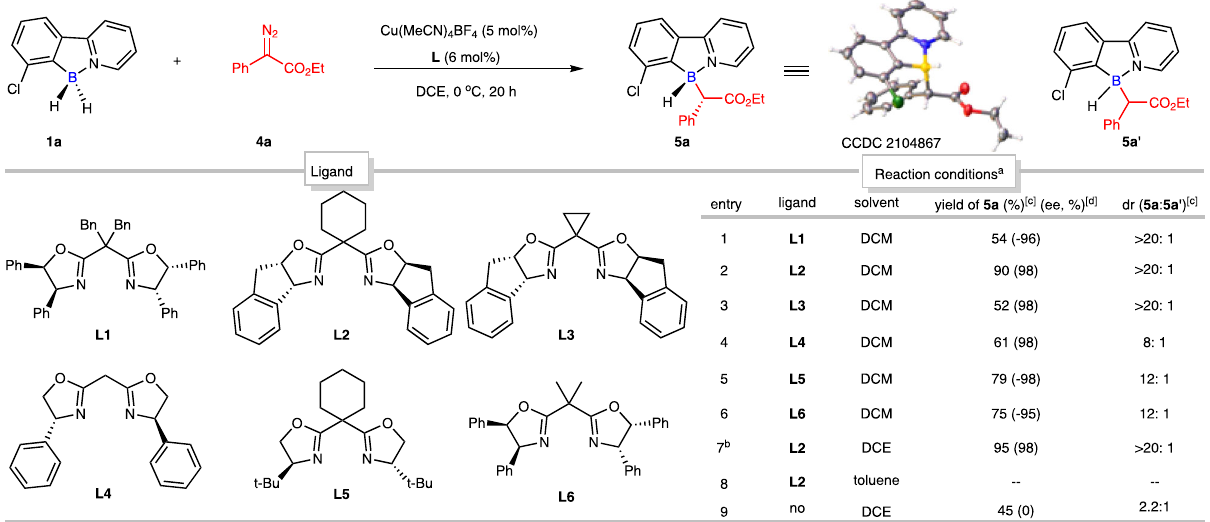
Fig. 6 Optimization of desymmetric B – H bond insertion reaction with ethyl α -diazophenylacetate (4a). Conditions: a 2-arylpyridine-borane ( 1a ) (0.12 mmol, 1.2 equiv), ethyl α -diazophenylacetate ( 4a ) (0.1 mmol, 1 equiv), Cu(MeCN) 4 PF 6 (5 mol%), ligand (6 mol%), solvent (1 mL) at 0 °C for 20 h. b Isolated yield. c Determined by 1 H NMR. d Determined by chiral